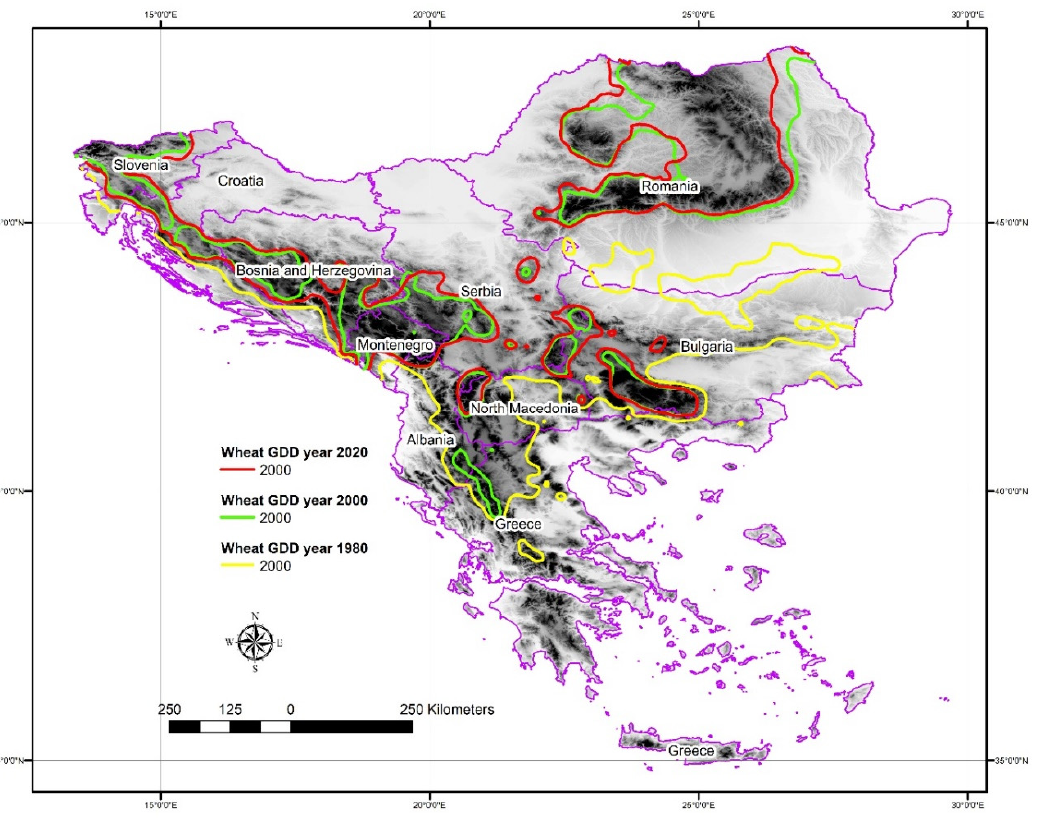
Figure 9. The spatiotemporal variation of the isolines of the 2000 GDD units for the wheat cultivation (for the years 1980, 2000, 2020).